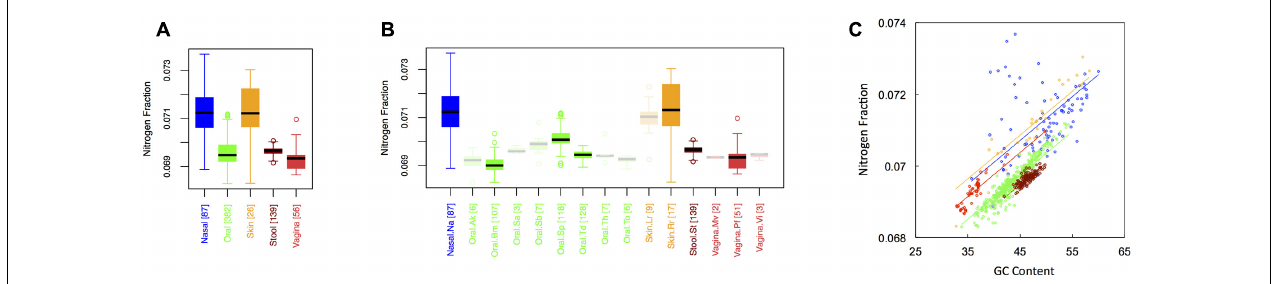
FIGURE 3 | Boxplots showing the average nitrogen content of microbial proteins as a function of human body site for (A) the 5 major sites and (B) the 15 minor sites in our study. The number of samples from each site is indicated in square brackets on axis labels. Faded boxes are used for sites with fewer than 10 samples. Differences in nitrogen content were tested with Dunn’s test. Statistics are summarized in Appendix II, Tables A.2.7, A.2.8; (C) Scatterplot of nitrogen content versus GC content with associated regression lines from our ANCOVA analysis for major body sites: nasal (blue), oral (green), skin (yellow), stool (brown), and vaginal